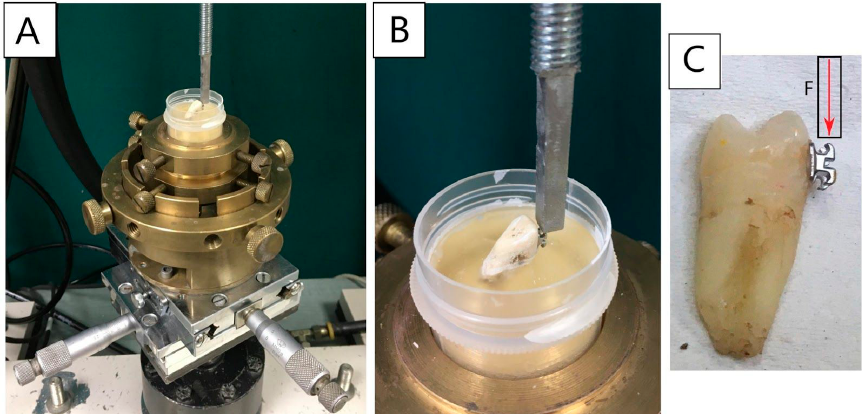
Figure 2. A working site prepared for the performance of shear bond strength test with a fixed sample and a picture of a tooth illustrating the direction of application of the load. ( A , B ) Method of placing the tooth in a measuring machine. ( C ) The direction of application of shear force.